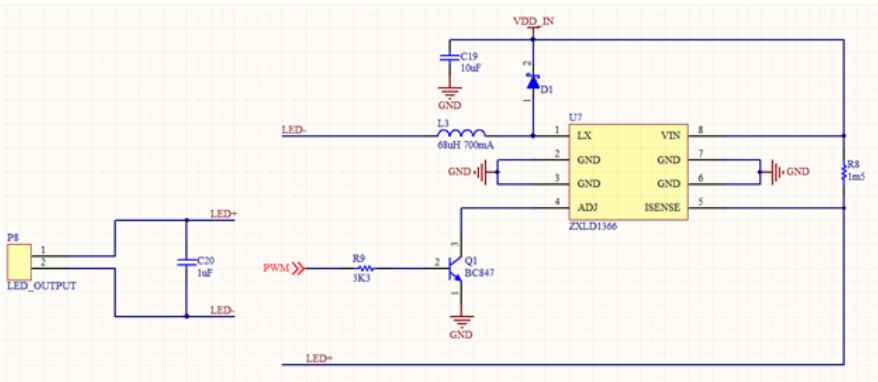
Figure 2. Schematic of the LED dimming stage.